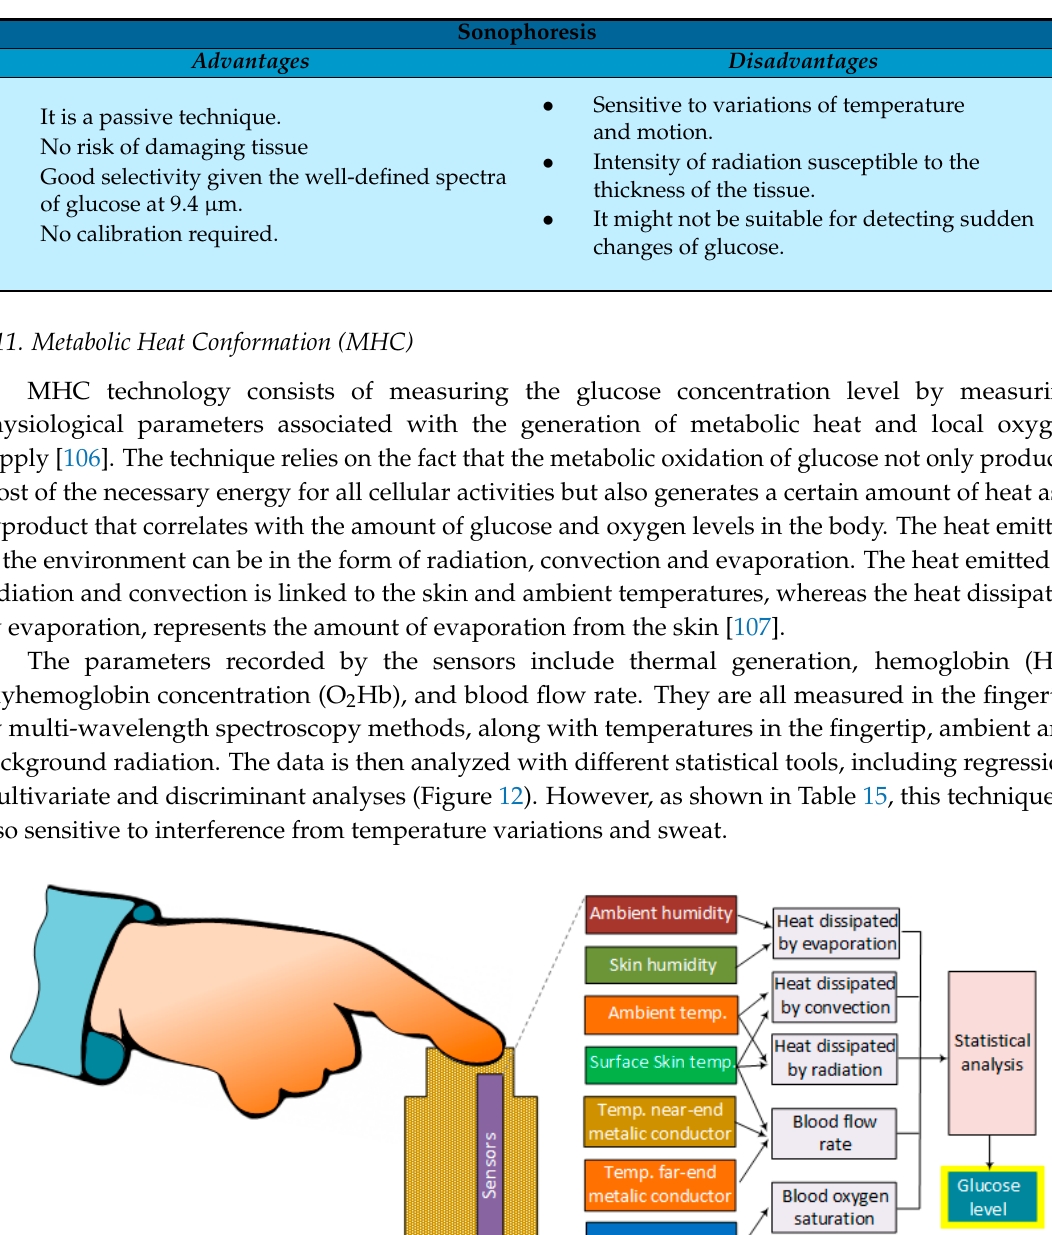
Table 14. Advantages and disadvantages of thermal emission spectroscopy.